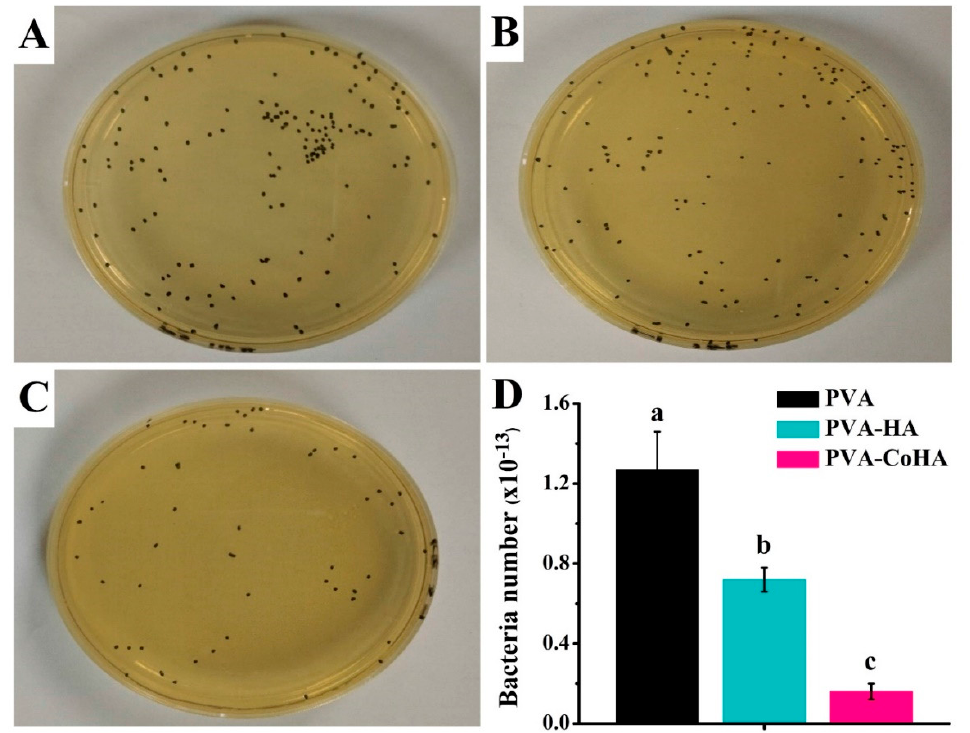
Figure 8. Evaluation of the antibacterial activity of ( A ) PVA, ( B ) PVA-HA and ( C ) PVA-CoHA nanocomposites against E. coli . ( D ) Bacteria adhesion on PVA and PVA-CoHA nanocomposites. Means with different letters ( a – c ) were significantly different ( p < 0.01, mean ± SD, n = 4).